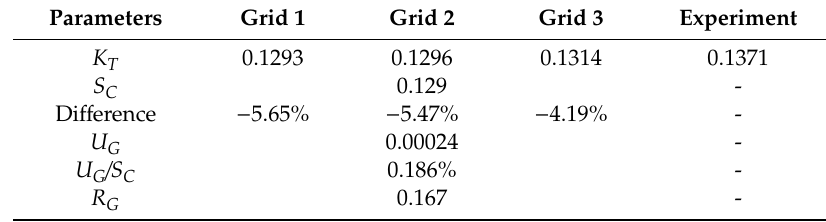
Table 6. The di ff erence between prediction and measurement of K T ; grid uncertainty, U G ; and convergence ratio, R G .